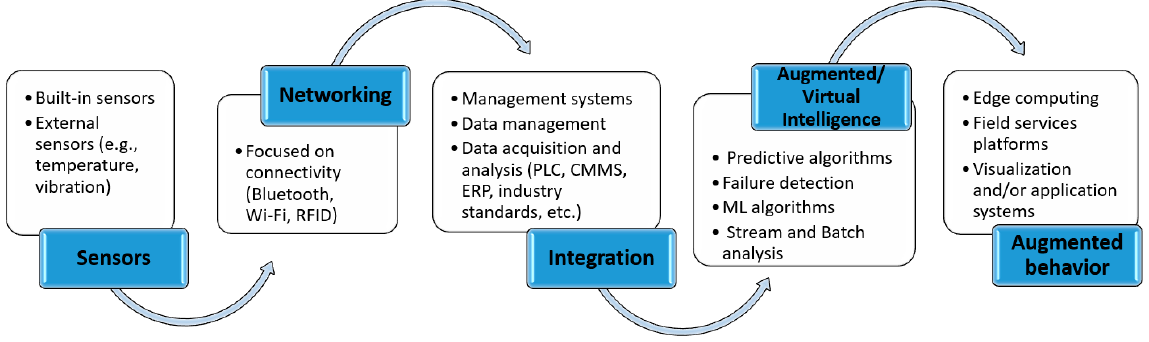
Figure 7. Technologies enabling PdM processes in the context of Industry 4.0. Source: own contribution based on [53,86,87].